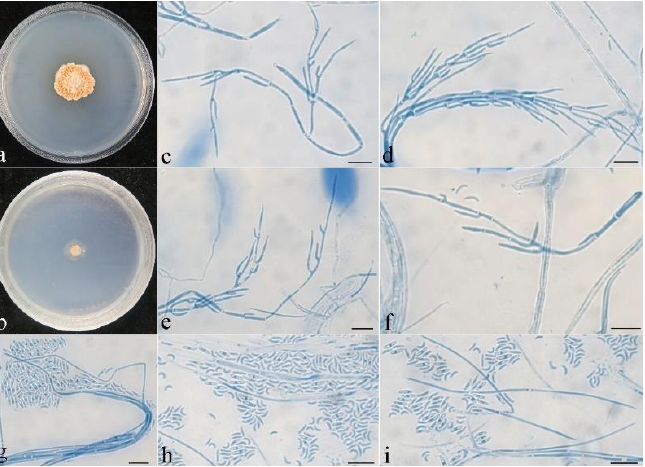
Figure 7. Colonial and microscopic morphology of Pseudocosmospora beijingensis (CGMCC 3.24131). ( a ) Colony after 1 week at 25 °C on PDA; ( b ) colony after 1 week at 25 °C on SNA; ( c – i ) conidiophores, phialides, and microconidia in lactophenol cotton blue. Bars: ( c – i ) = 10 μm. Thelonectria globulosa Z.Q. Zeng & W.Y. Zhuang, sp. nov. Figures 8 and 9. Fungal Names: